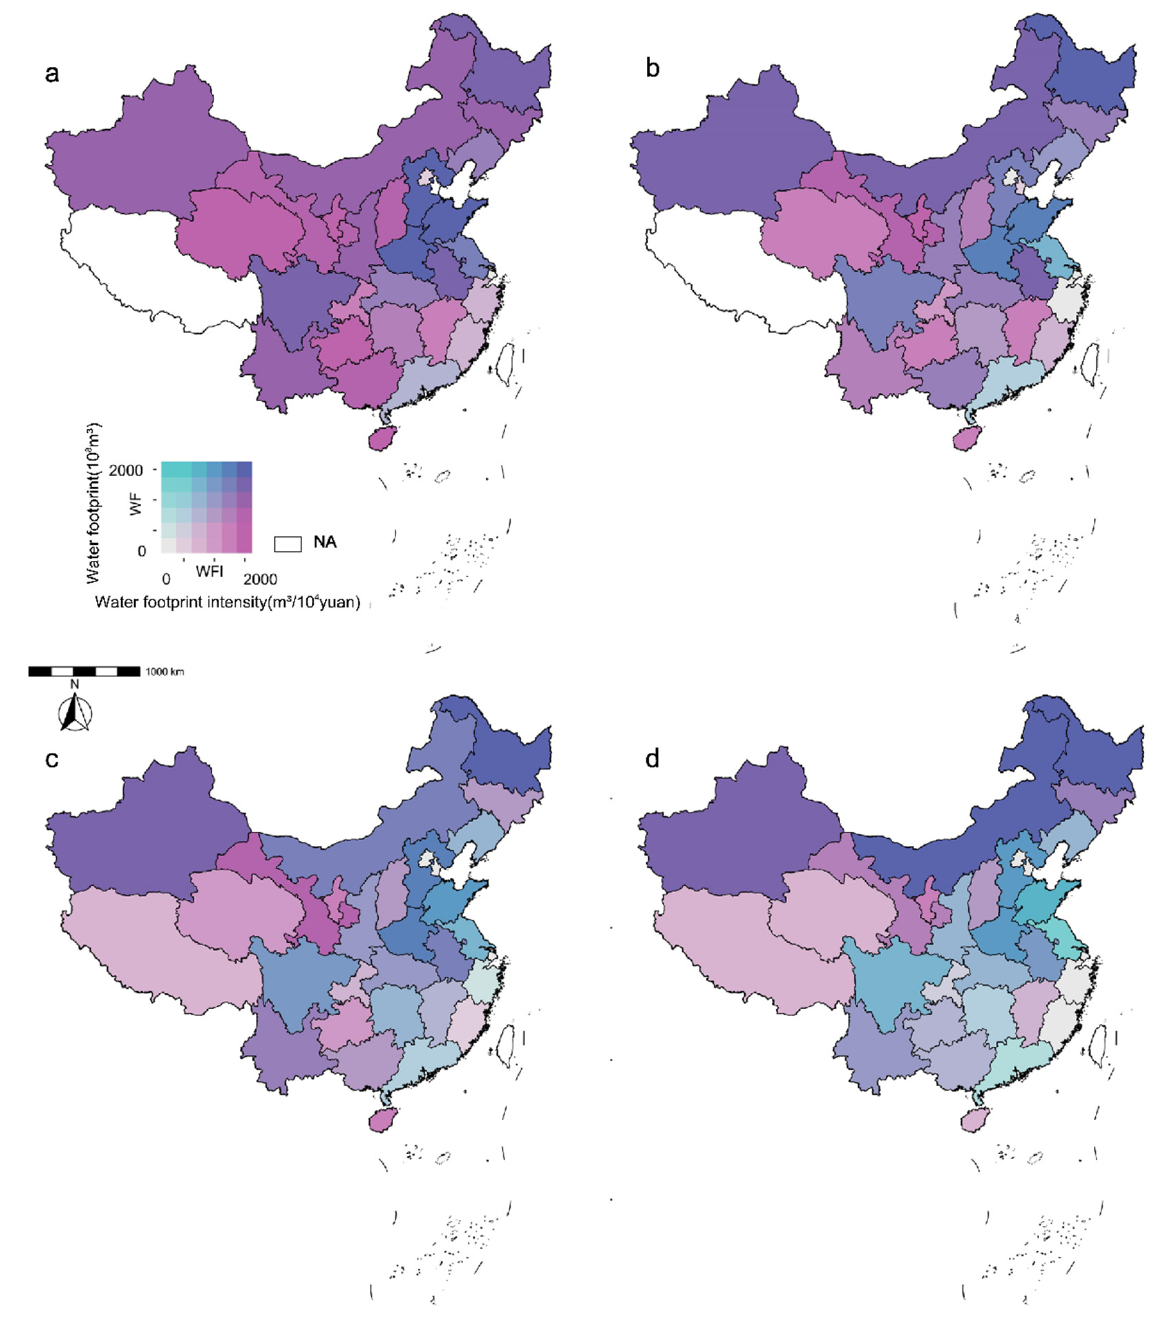
Figure 3. Water footprint and water footprint intensity on the provincial level from 2002–2017. a, b, c, d represents the situation of 2002, 2007, 2012 and 2017, respectively.